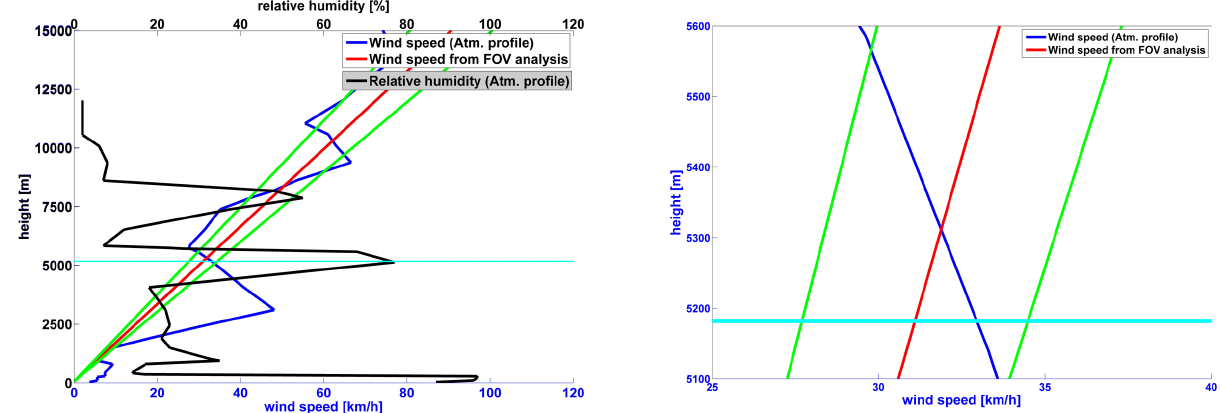
Fig. 13. Left: crossing measured wind velocity (blue line) with hypothesized possible wind velocities from FOV analysis (red line with green error lines). Notice the crossing points correspond to a high humidity layer (black line). Right: zooming in on the 5310m crossing point. The cyan line is the cloud base height (5182m) extracted by a nearby ceilometer (Website: “Station Observations”).